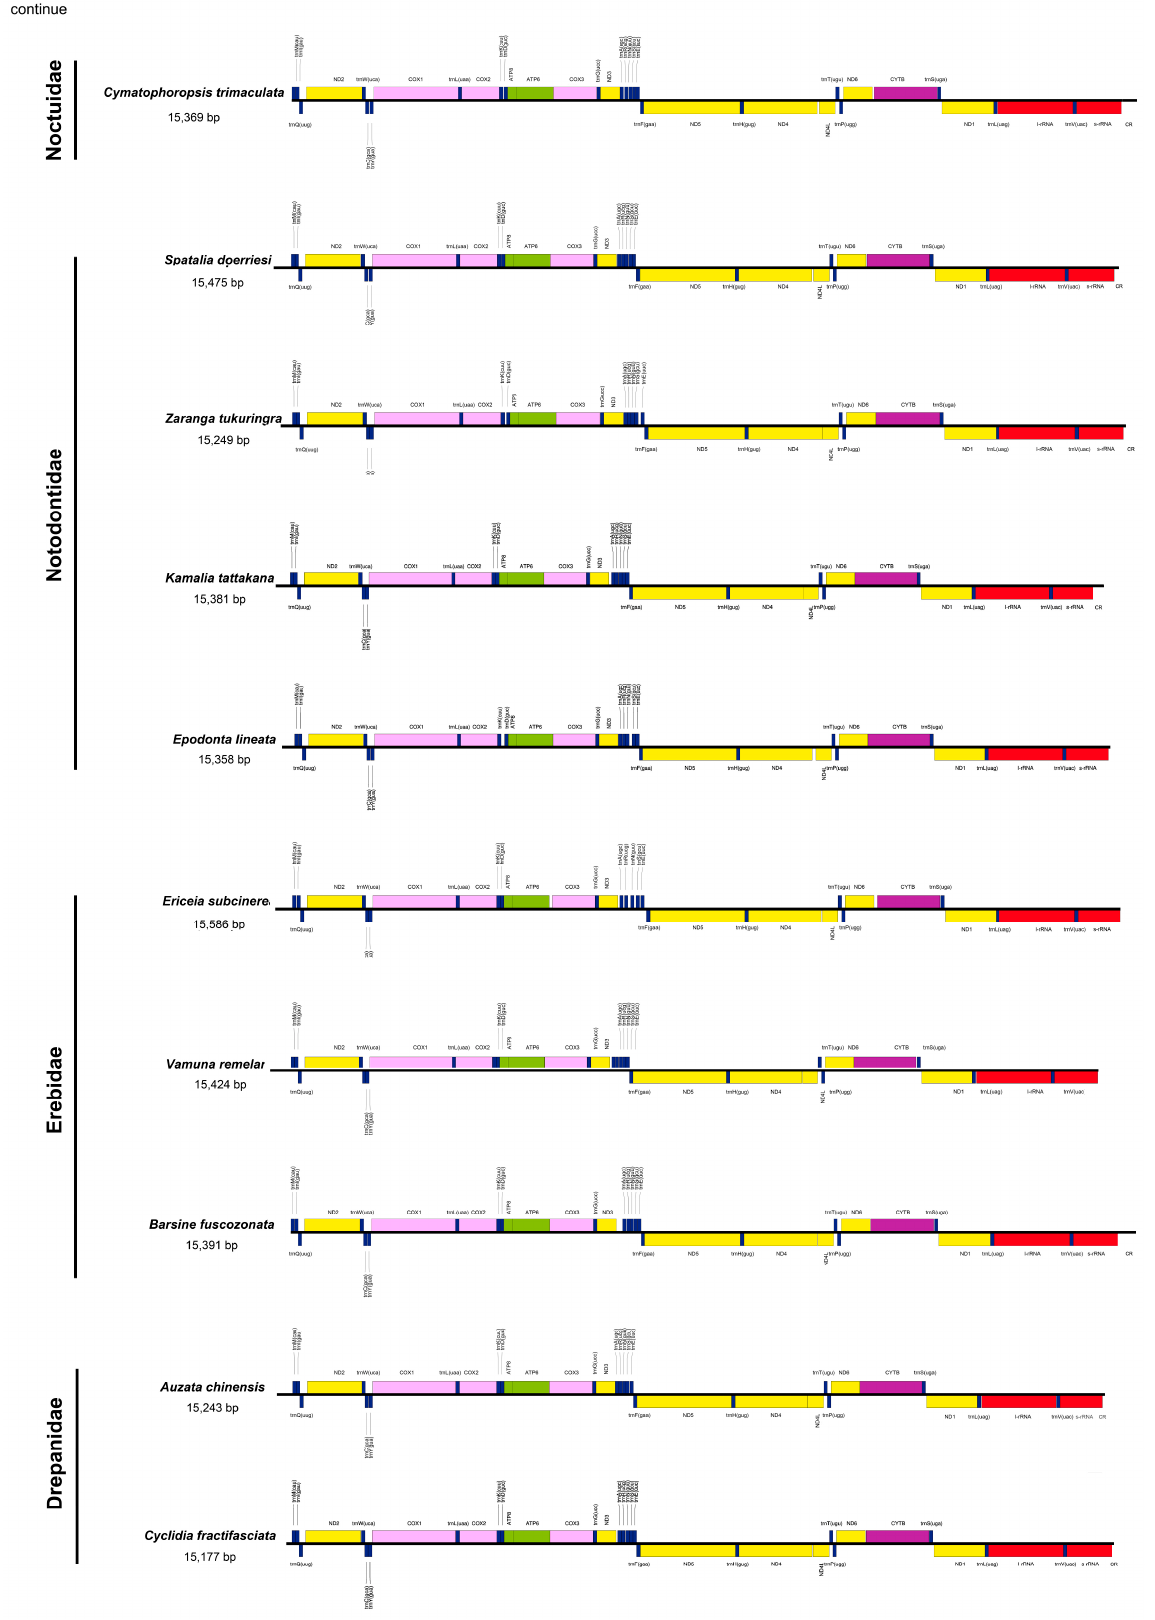
Figure 1. Organizational maps of the nineteen newly sequenced mitogenomes in this study. The genes and intergenic spacers are scaled to their length in the mitogenome. Abbreviations: COX1